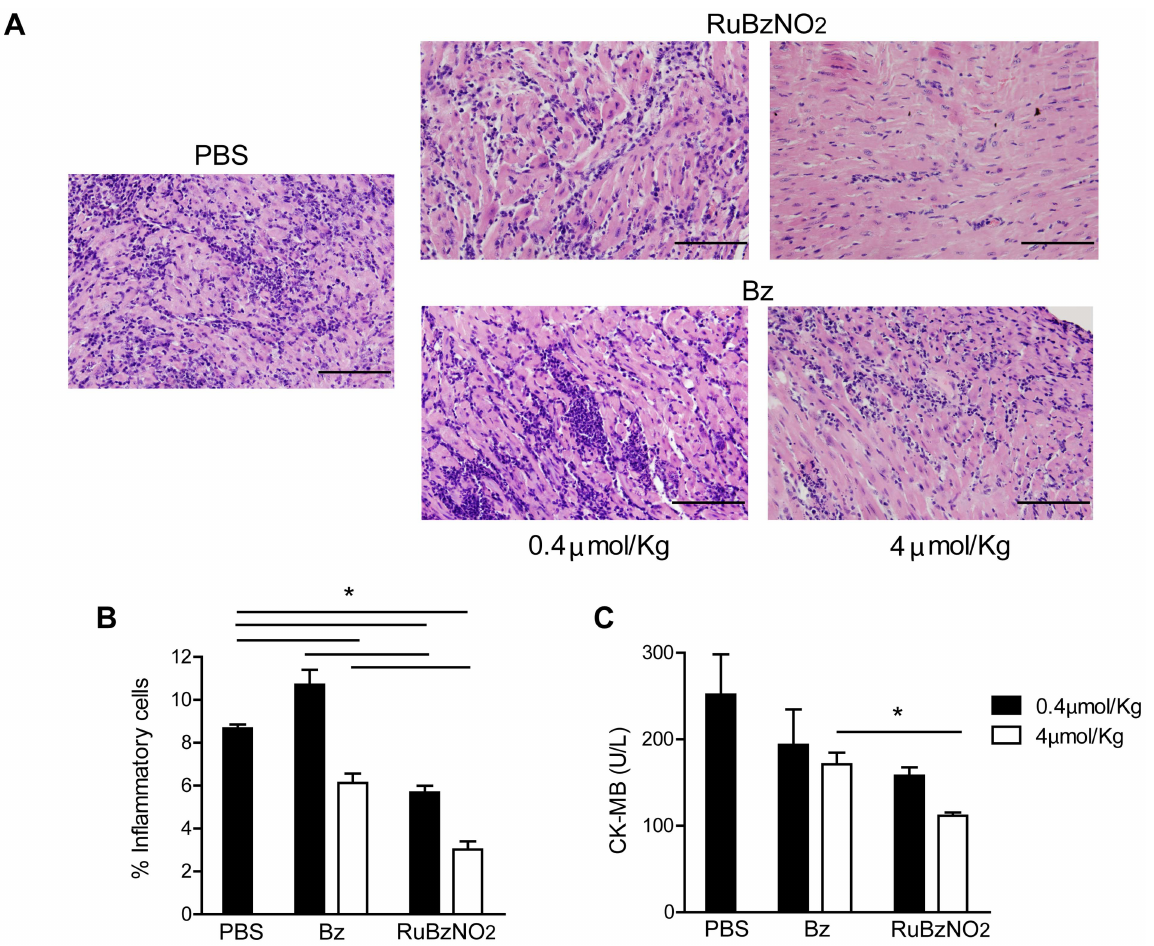
Figure 5. Treatment with RuBzNO 2 ameliorates heart inflammation and lesions induced by T.cruzi infection. Mice were infected with 2000 trypomastigotes of T. cruzi and treated from day 5 for 10 days with various concentrations of Bz or RuBzNO 2 . Twenty days after infection, the heart histology (A–B) was evaluated, and the CK-MB level (C) was measured in the serum. A. Representative photomicrograph of heart stained with H&E. B. Quantification of the inflammatory cells shown in A. The bars indicate means + SEM of 4–6 mice/experiment and are representative of two independent experiments. * represents p , 0.05.